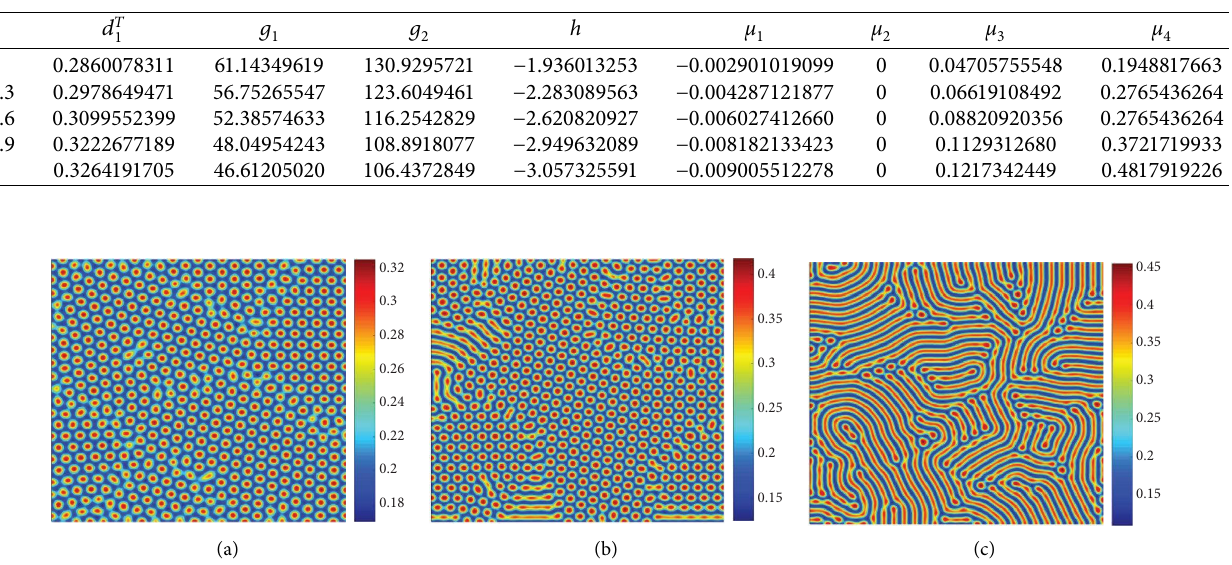
, (b) μ < μ � 0 . 26 < μ 3 3